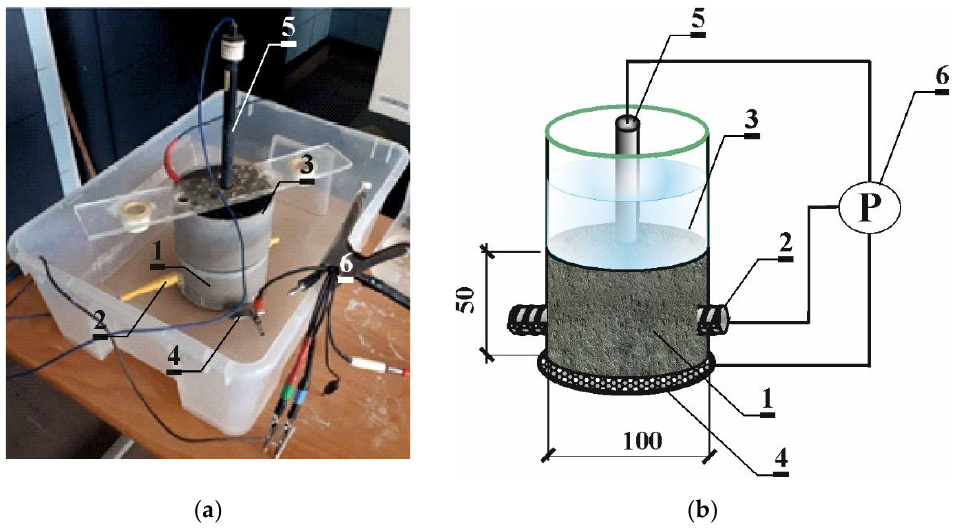
Figure 2. The applied test stand for polarization tests with the LPR method ( a ) view; ( b ) scheme: 1 — concrete test specimen, 2 — ribbed rebar ø12 mm made of steel B500S (working